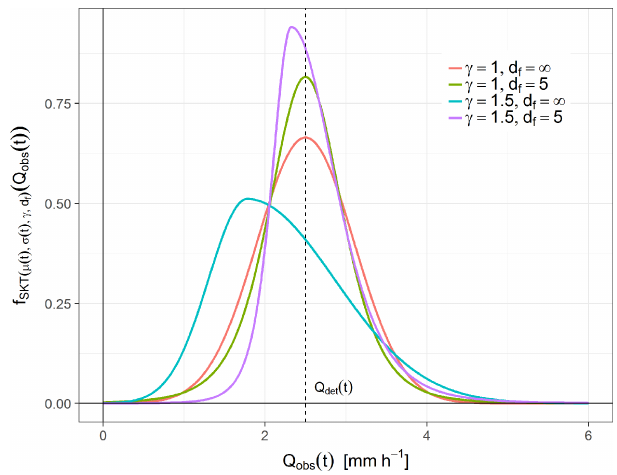
Figure 1. Example of skewed Student’s t distributions with E [ D Q ] = Q det (t) = 2 . 5mmh − 1 and standard deviation σ D 0 . 6mmh − 1 for different values of skewness, γ , and degrees of free- dom, d f